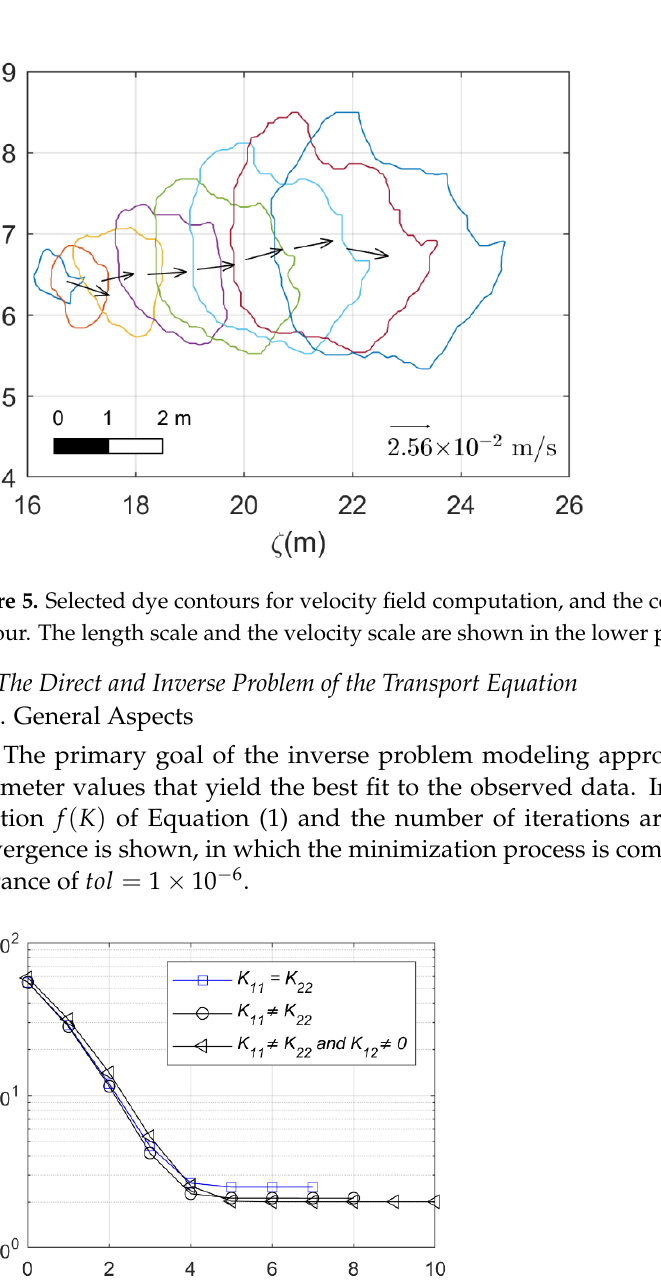
Figure 6. Objective function and number of iterations, with 𝐾 11 = 𝐾 22 and 𝐾 11 ≠ 𝐾 22 .